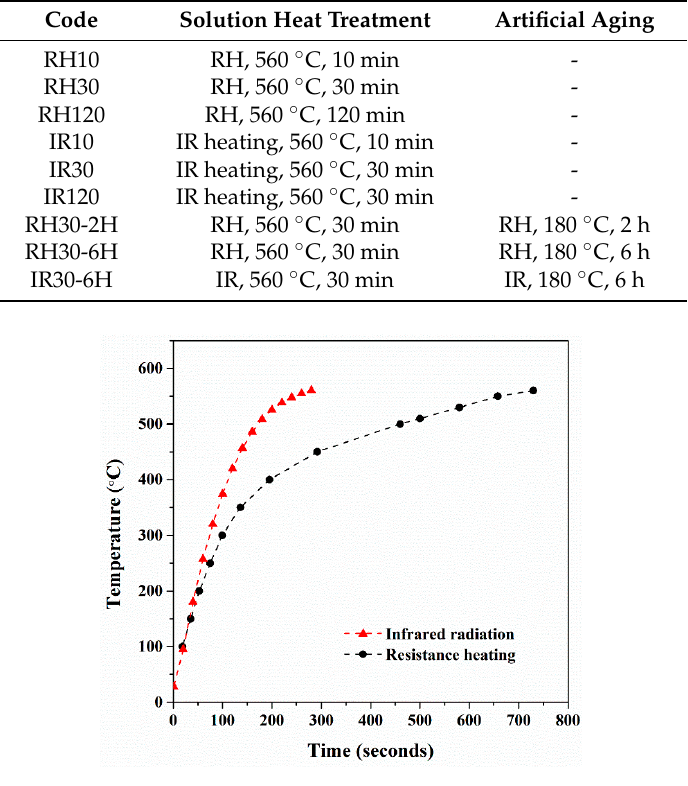
Figure 2. Comparison of temperature profiles between specimen heated in resistant heat (RH) furnace and that heated in IR